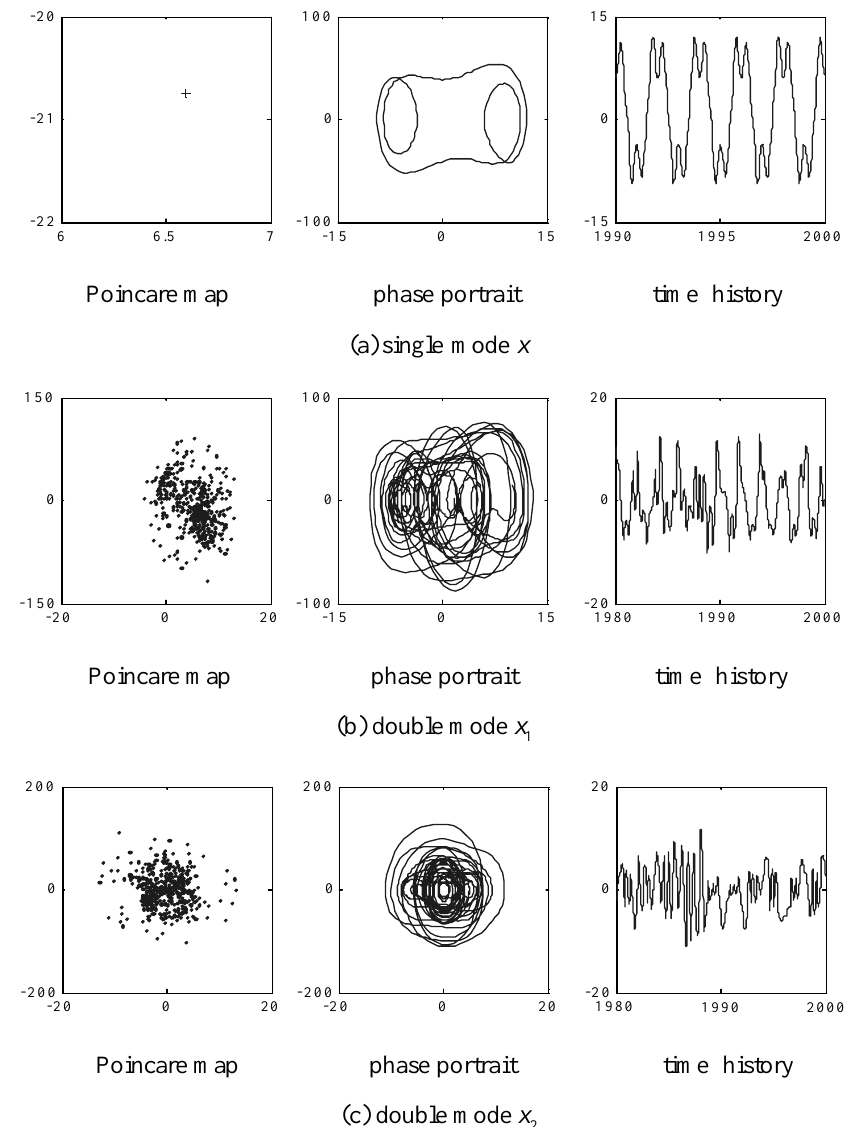
Fig. 7. Comparison between single and double mode models ( ω = π,g = 500